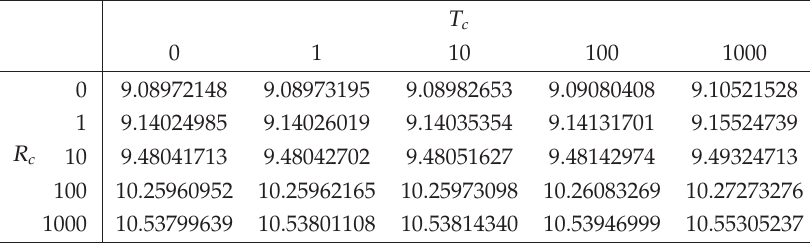
Table 5.5 . Values of coe ffi cients λ the intermediate point elastically restrained against rotation and